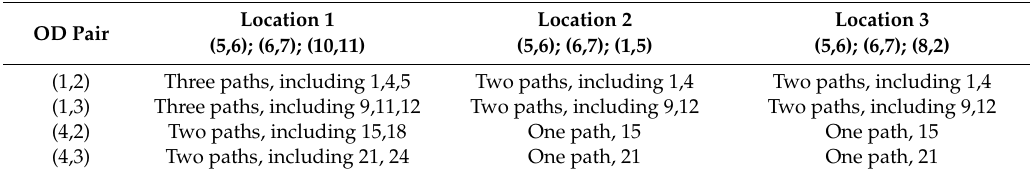
Table 4. The changes in the location of charging stations (CSs) and feasible